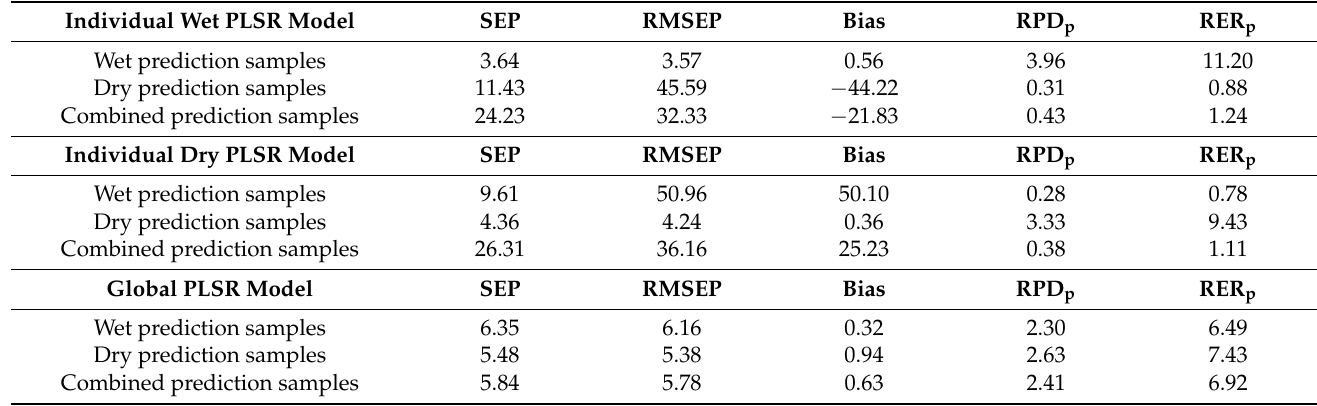
Table 4. Prediction results for individual and combined prediction samples using the best individual and global PLSR models. The SEP, RMSEP, and bias were expressed in % ( w / w